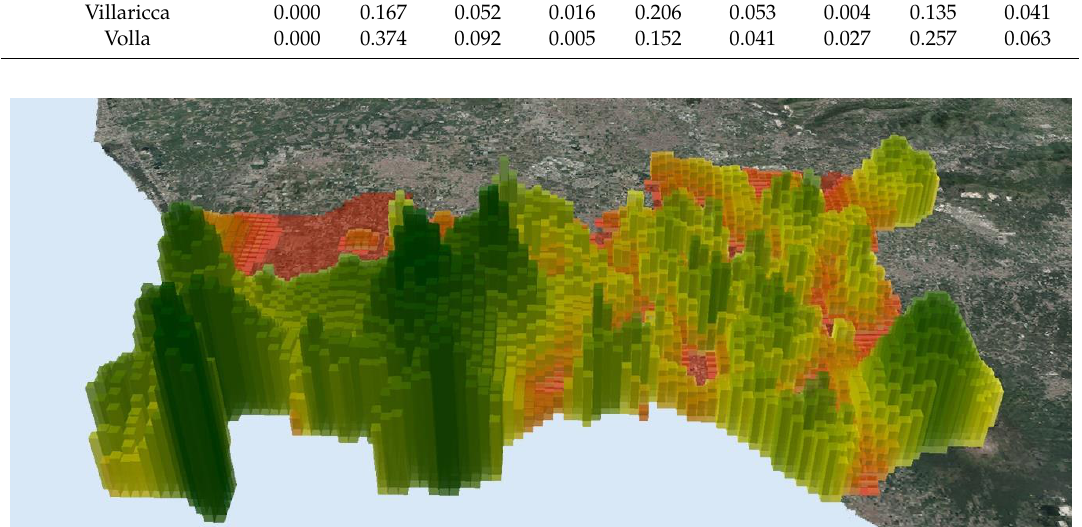
Figure 6. 3D visualisation of Regulation Services values with Jenks natural breaks categorisation. The colour gradient and histogram height show high (green) and low (red) UES values.